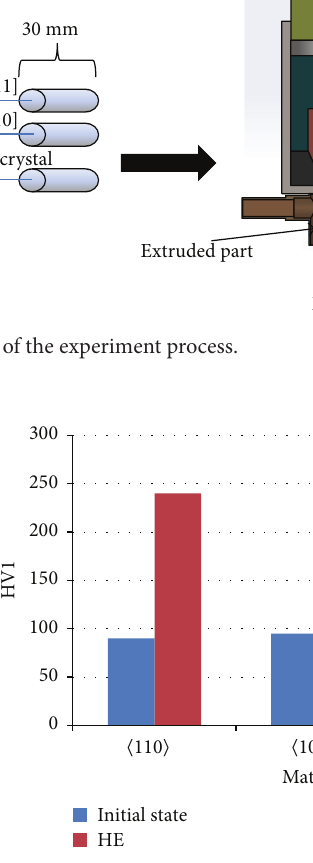
Figure 2: Comparison of the microhardness of polycrystalline Ni and the two ⟨110⟩ and ⟨100⟩ single crystals in the initial state and after HE 𝜀 = 1.2